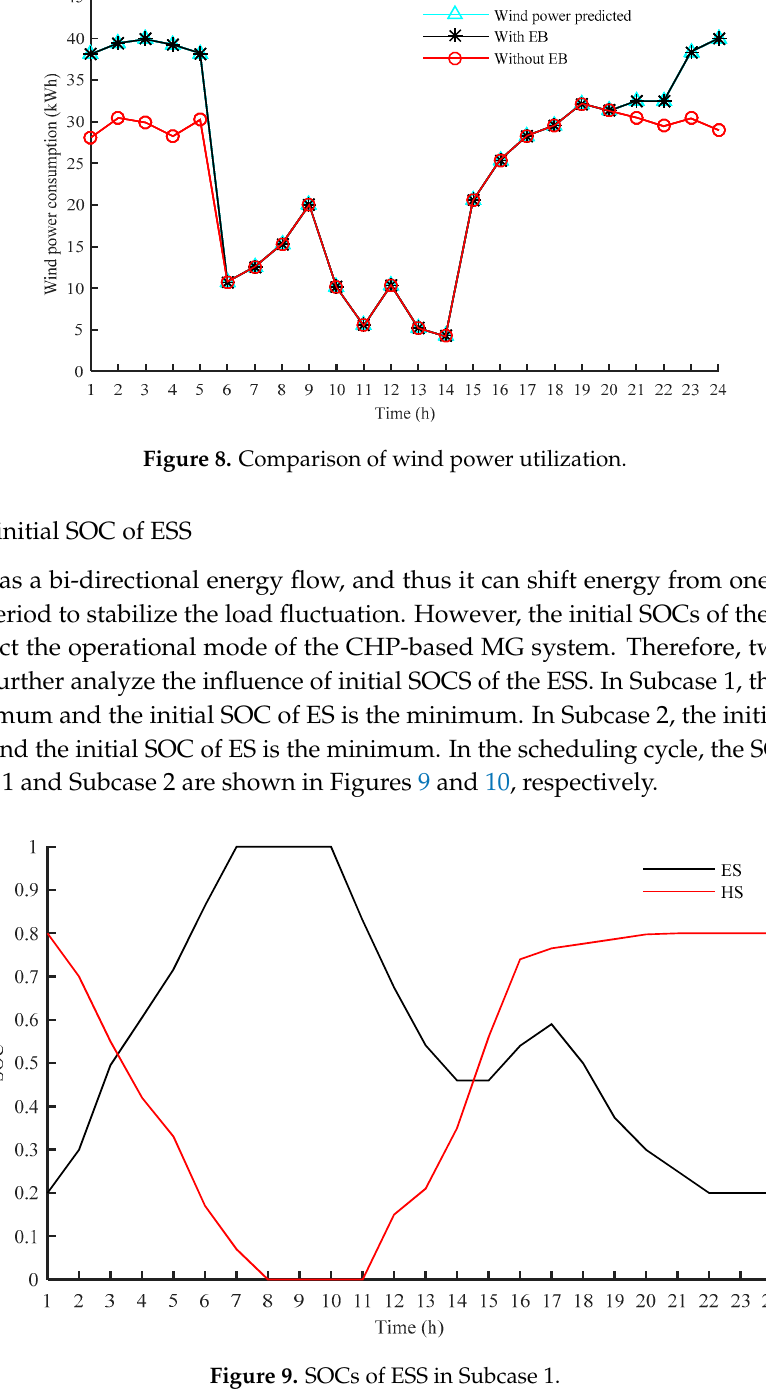
Figure 10. SOCs of ESS in Subcase 2. From the comparison results between Figure 9 and Figure 10, it can be seen that the ES can coordinate with the HS in Subcase 1. In Subcase 1, the battery is fully charged and the heat storage tank discharges significantly at night, which reduces the CHP unit output. When heat load is small and electricity load are large during the daytime, the HS is charged with heat and the ES discharges electricity. In Subcase 2, Figure 10 shows that the ES cannot complement well the HS due to lower initial SOC of HS. More power output of the CHP unit is used to meet the heat load because the heat load is larger at night. There is no excessive heat to store and the stored electricity of the ES is also decreased. The HS stores heat after 11:00 a.m. and releases heat after 8:00 p.m. Therefore, as shown in Table 7, both the economic cost and environmental cost of Subcase 1 are lower than those of Subcase 2.